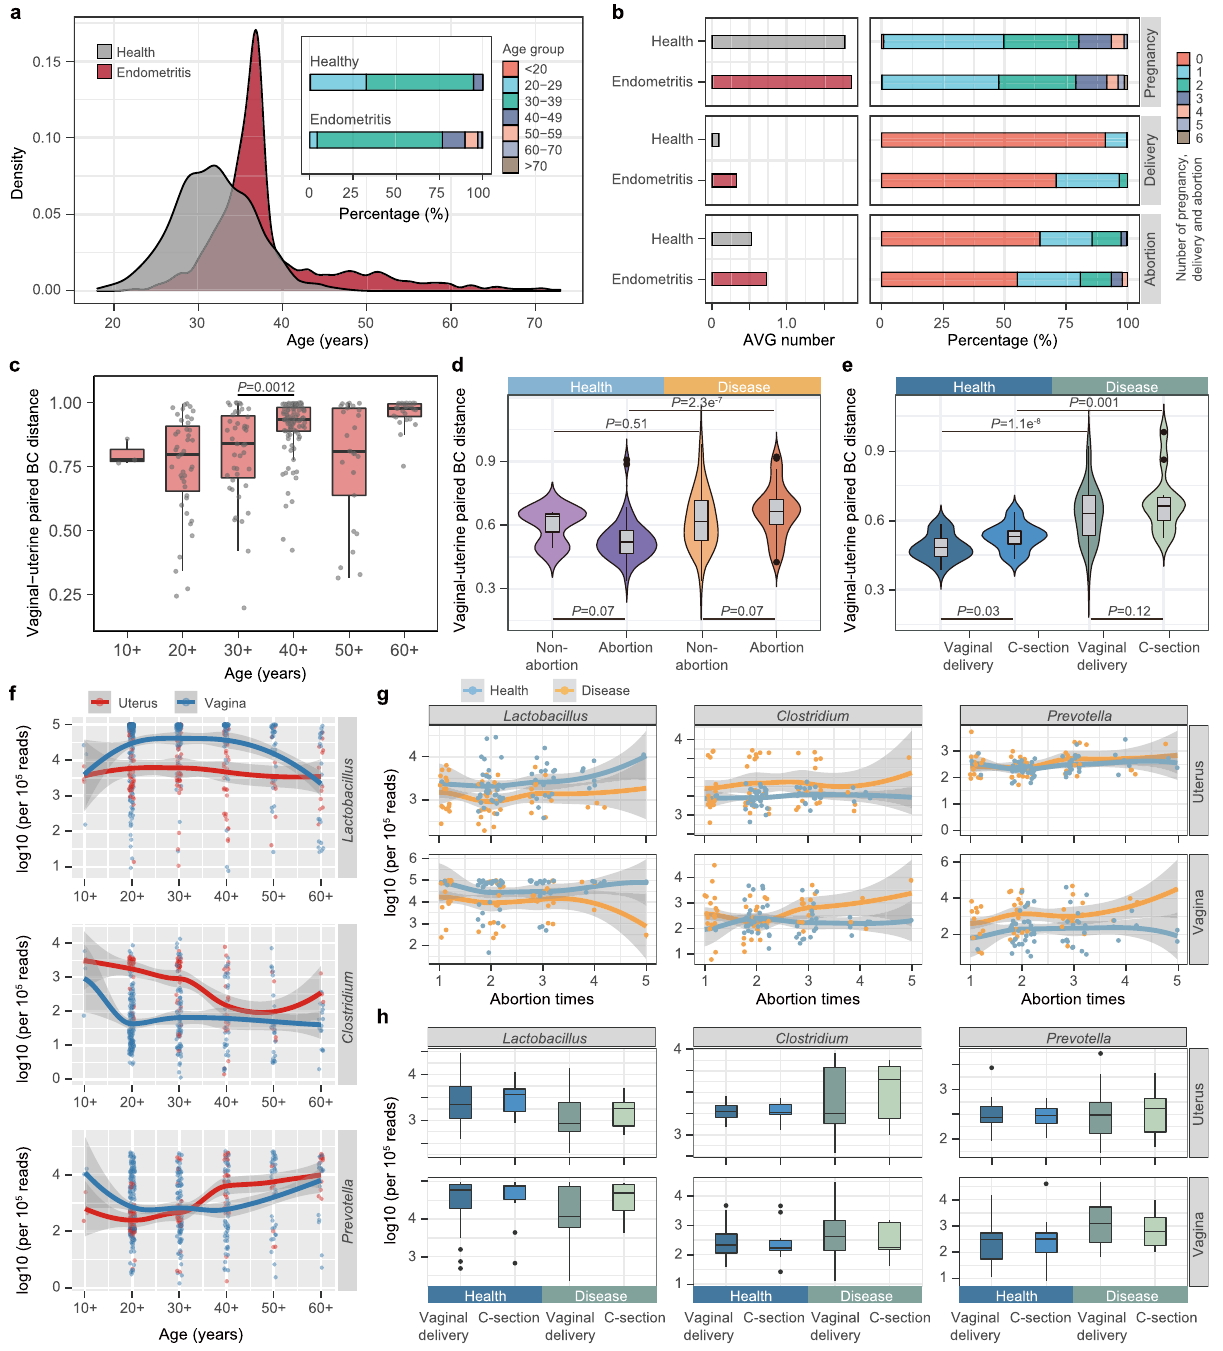
Fig. 3 Synchronous variations in the uterine and vaginal microbiome and the correlation to clinical factors. a The age distribution of 1,612 women interviewed from two hospitals. b The average (AVG) number and percentage of pregnancies, deliveries, and abortions in women with and without chronic endometritis. c Bray-Curtis (BC) community distance of the paired uterine and vaginal samples with age. The scales 10 + , 20 + , 30 + , 40 + , 50 + , and 60 + on the x -axis represent ages <20, 20 – 29, 30 – 39, 40 – 49, 50 – 59, and ≥ 60, respectively. d BC distance of uterine-vaginal paired samples associated with abortion history. The distance was calculated at the OTU level in the microbiome of women with and without chronic endometritis. e BC community distance of uterine-vaginal paired samples associated with the previous delivery mode. f The relative abundance of three bacterial genera in the uterine (red) and vaginal (blue) microbiome with age. The values were normalized to 10 5 reads in each sample. g Relative abundance of three bacterial genera along with the number of abortions. h Relative abundance of three bacterial genera along with the previous delivery mode. For c – e and h , box and violin elements are de fi ned as: center line, median; box limits, upper and lower quartiles; whiskers, 1.5× interquartile range; points, outliers; the width of the violin represents the density distribution. P values were determined by two-tailed Wilcoxon test. For f , g the shadow around the linear regression trendline shows the 95% con fi dence interval (CI).